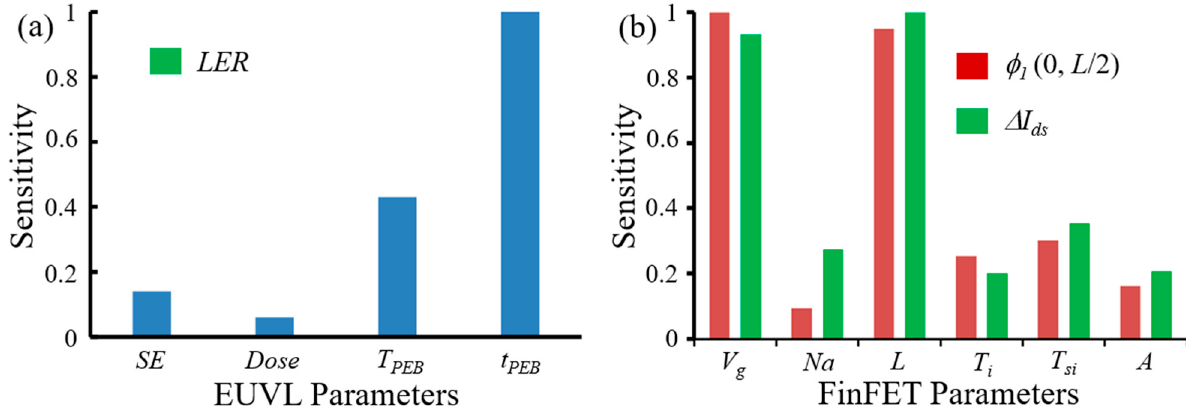
Figure 9. Parameter sensitivities: ( a ) LER ; ( b ) electric potential ( ϕ 1 ) and drain current ( ∆ I ds ). Parameter sensitivities are normalized by the most sensitive parameter. EUVL parameters are secondary electron ( SE ), exposure dose ( Dose ), PEB temperature ( T PEB ), and PEB time ( t PEB ). FinFET parameters are gate voltage ( V g ), doping concentration ( N a ), channel length ( L ), oxide thickness ( T i ), fin width ( T si ), and FWR amplitude ( A